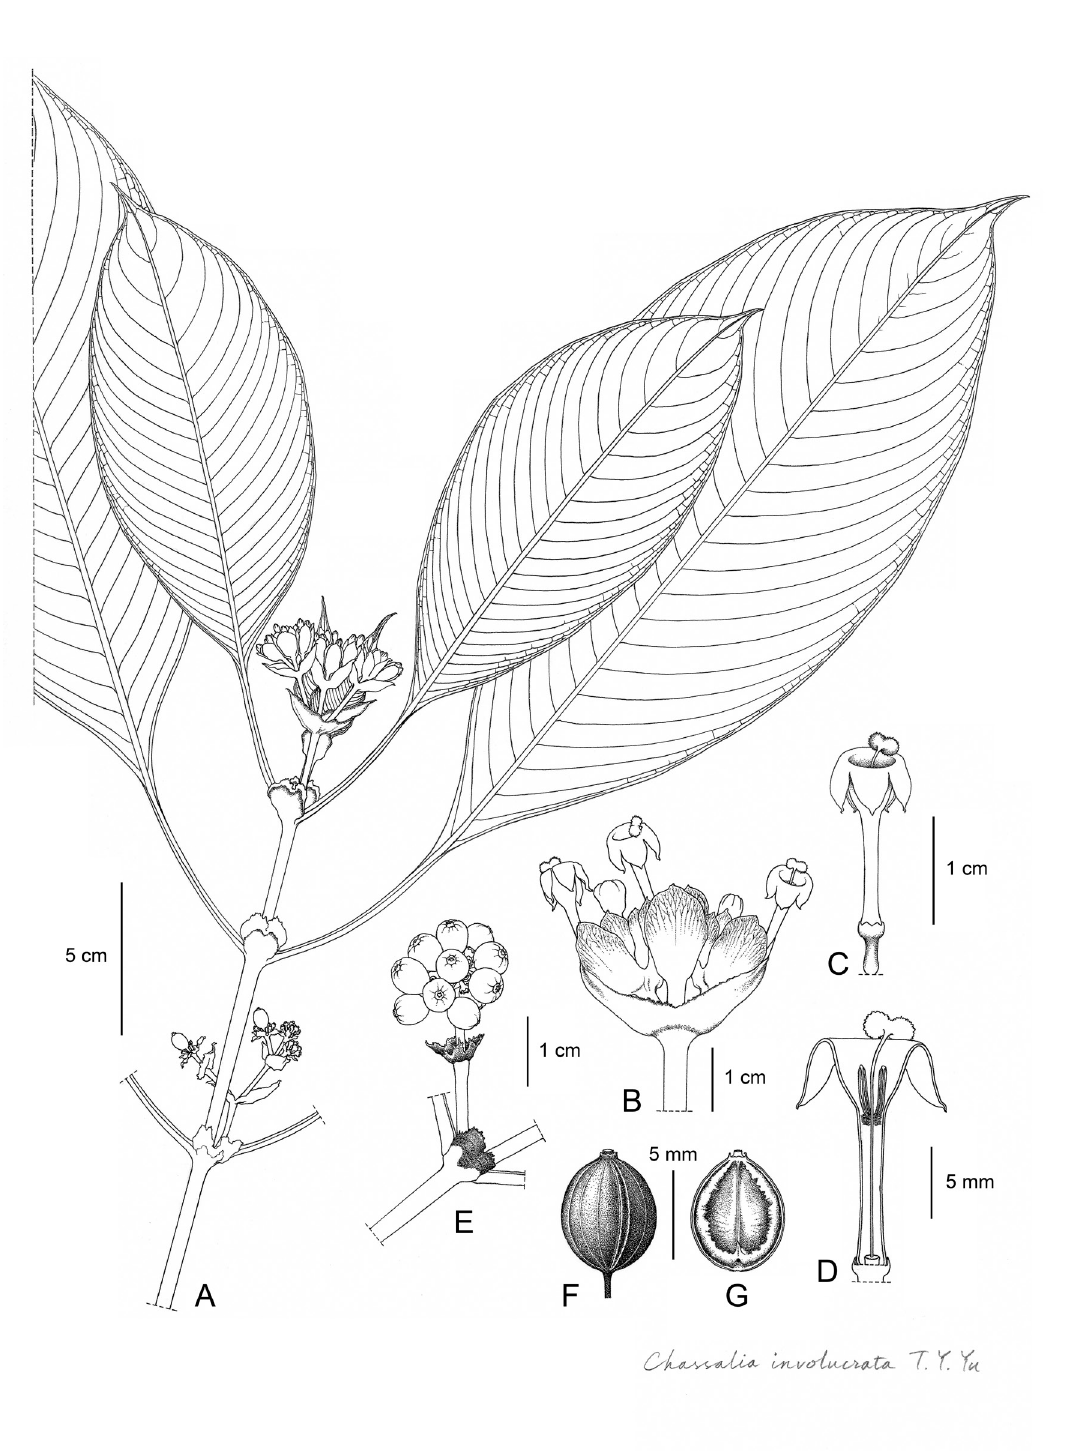
Fig. 12. Chassalia involucrata T.Y.Yu sp. nov. A . Flowering shoot. B . Inflorescence. C . Flower. D . Longitudinal view of corolla showing stamens, band of hairs, stigma, style and disc. E . Infructescence with stem node showing fresh fruit. F . Dry fruit. G . Pyrene ventral surface. A, C–D, F–G from Carlo Hansen 1608 ; B, E from photographs of living plants in Ulu Temburong National Park, Brunei, taken by Mr Y.W. Low. Drawn by T.Y.